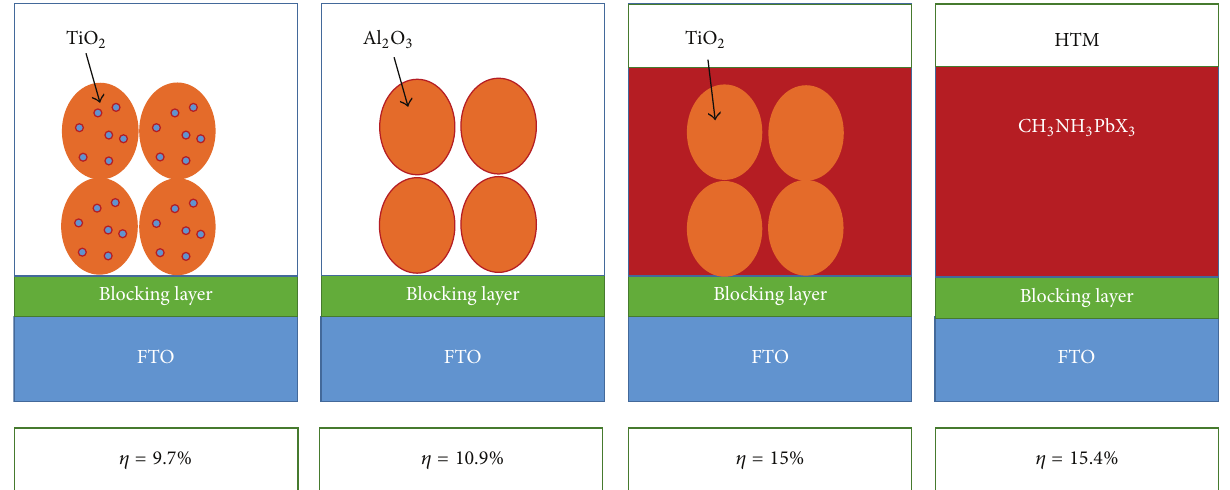
Figure 3: Progress in perovskite solar cells, from PCE of 9.7% through 10.9%, 15%, and 15.4% using device architectures ranging from titania sensitized with active layer to mesosuperstructure, inert scaffold, and planar p–n